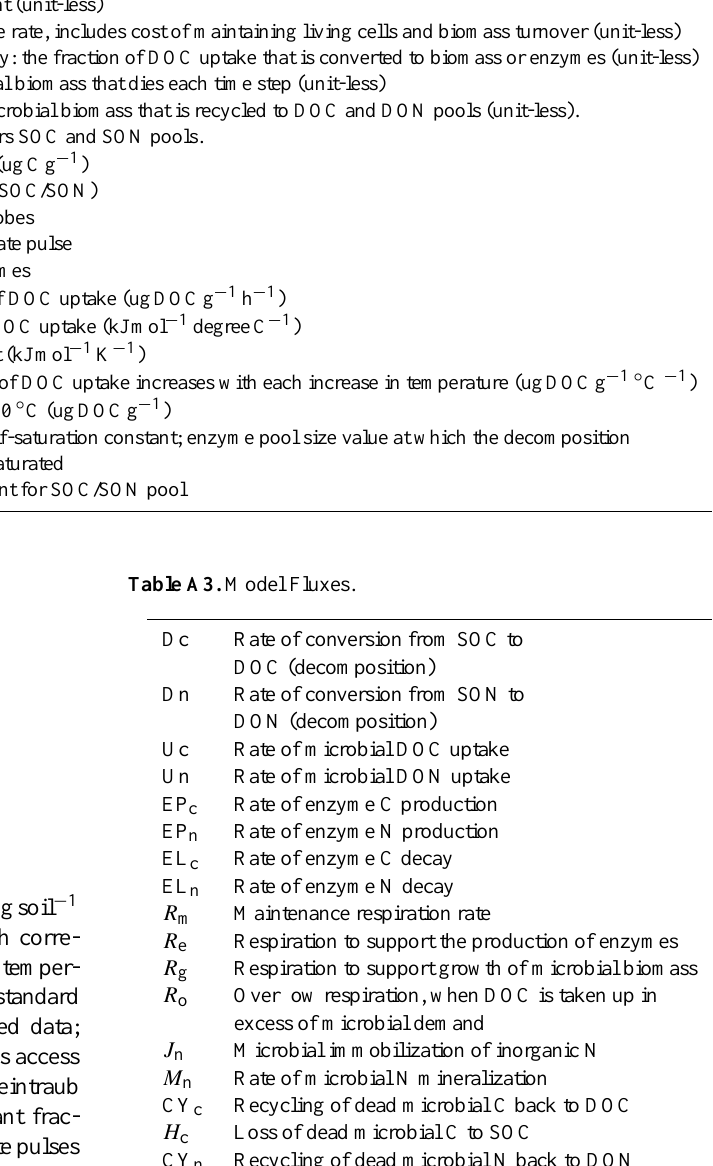
Table A1. Model parameters. List of parameter abbreviations, typical values, and definitions. K ep 0.0005 Rate of enzyme production per unit microbial biomass (unit-less) K l 0.05 Enzyme decay constant (unit-less) 0.01 Microbial maintenance rate, includes cost of maintaining living cells and biomass turnover (unit-less) 0.5